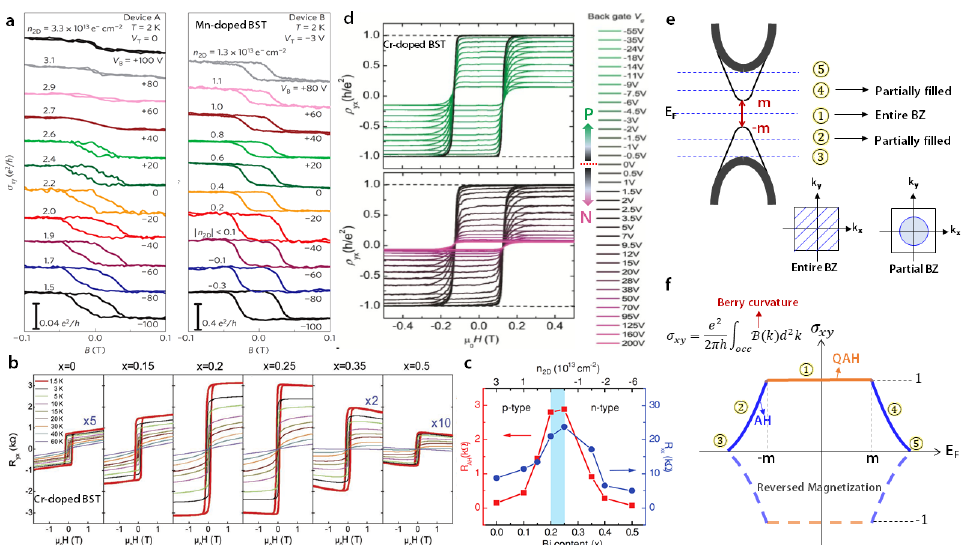
Figure 6: AH / QAH loops of various magnetic TI films . a, Sign of the AH hysterisis loops remains the same for the entire carrier range from n to p-type for MBE-grown Mn-doped (Bi,Sb) Te films. The disappearance of the loop at high carrier density, 2 3 when the Fermi level is deep in the bulk conduction band, indicates that the ferro- magnetism is not mediated by bulk carriers ( adapted from ref. [ 265 ] ). b, Sign of the AH hysterisis loops remains the same for the entire Bi doping concetration in Cr-doped (Bi Sb ) Te and is independent of the carrier type, which can be tuned x 1 − x 2 3 from p to n upon adding Bi, as shown in c ( adapted from ref. [ 264 ] ). d, The positive QAH loops for Cr-doped (Bi,Sb) Te films (adapted from ref. [ 61 ] ). The sign of the 2 3 loop remains the same for the entire gate-voltage range and even when the system is far from the quantized regime. e, Schematic band structure of a magnetically- doped TI. Magnetic doping / proximitizing induces an exchange gap of 2m as well as a Berry curvature in the band structure. The Hall conductance can be written (cid:82) = e 2 (cid:66) d 2 k (i.e. the integral of Berry curvature (cid:66) over the entire oc- as σ x y 2 π h occ cupied states). If the integration covers the entire Brillouin-zone, which is the